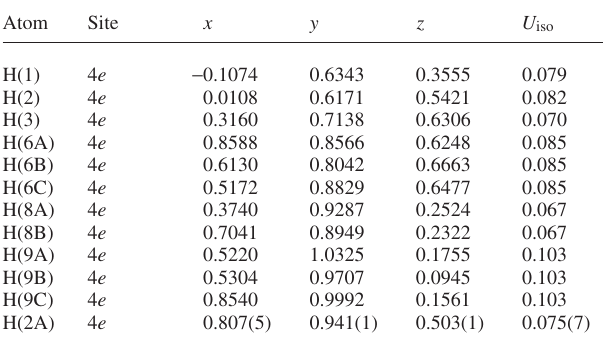
Table 2. Atomic coordinates and displacement parameters (in Å 2 )